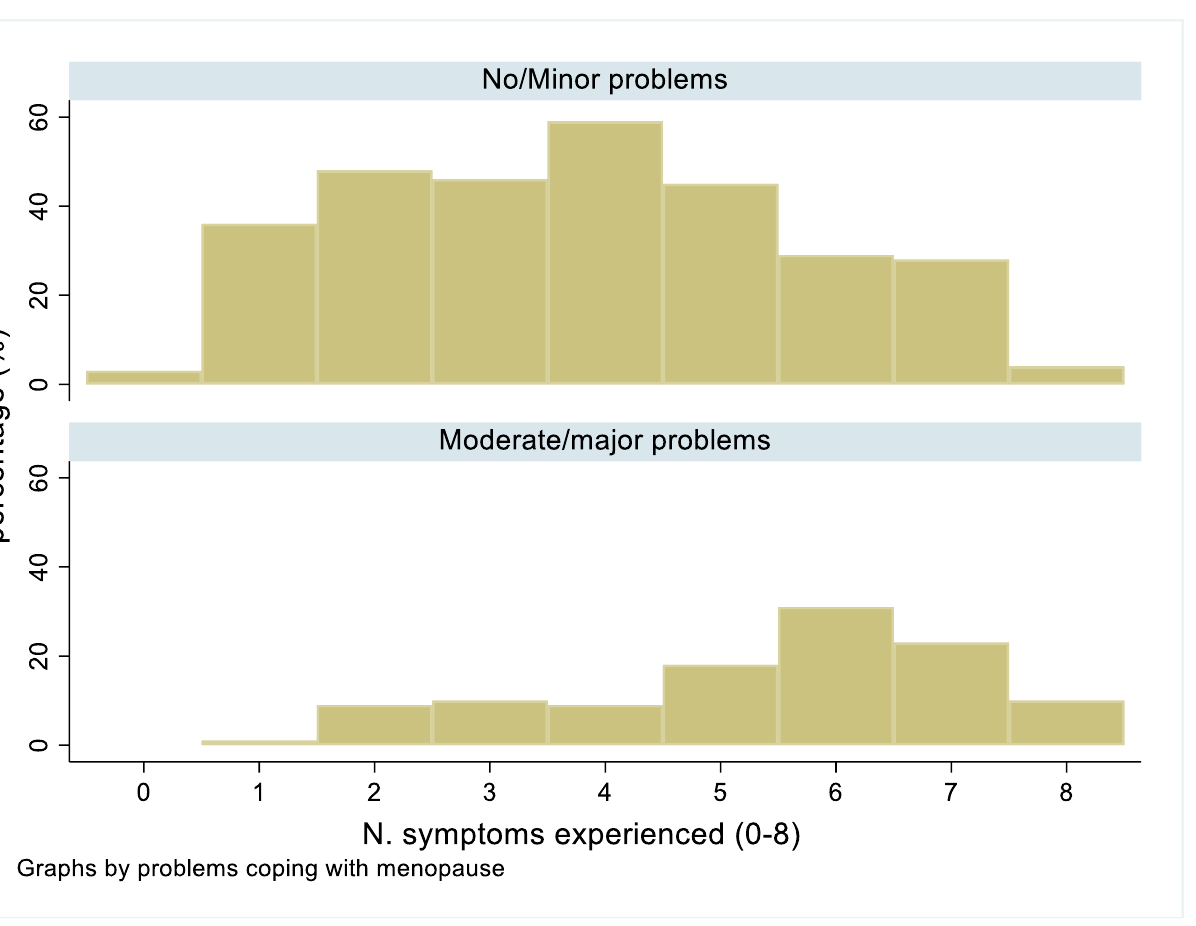
Figure 2. Comparison of the numbers of symptoms reported by women who reported no/minor problems coping with their symptoms at work as compared with those who reported moderate or major problems.